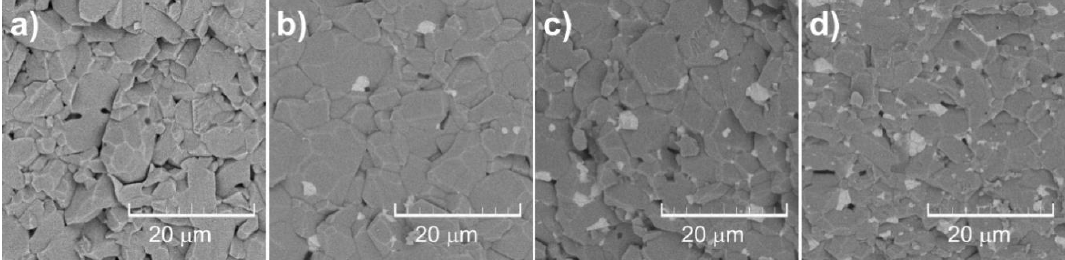
Figure 7. Surface fracture of Al 2 O 3 –ZrO 2 composite ceramics with different content of ZrO 2 : ( a ) 0 wt. %; ( b ) 1 wt. %; ( c ) 5 wt. %; ( d ) 10 wt. % prepared by slip casting and sintering at 1650 °C.